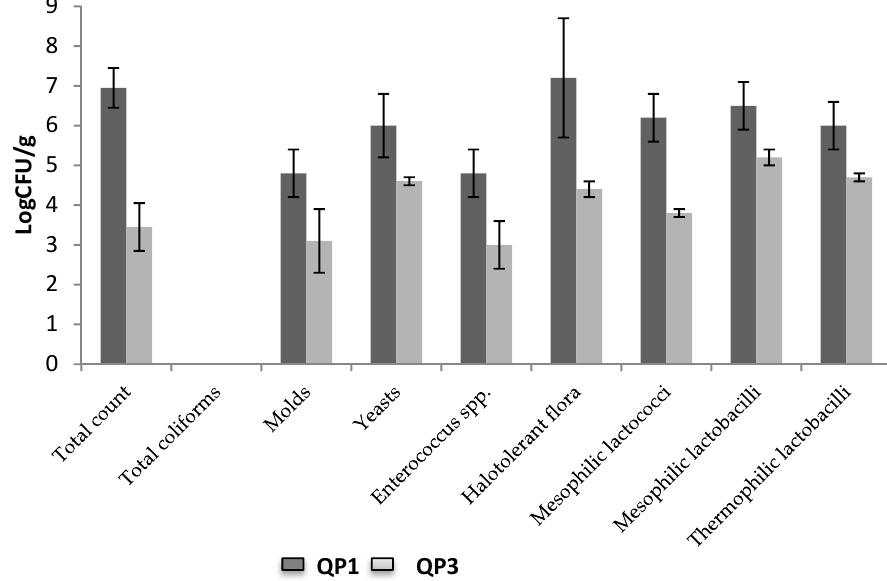
Figure 5. Average bacterial population in Poro cheese (Log CFU/g).